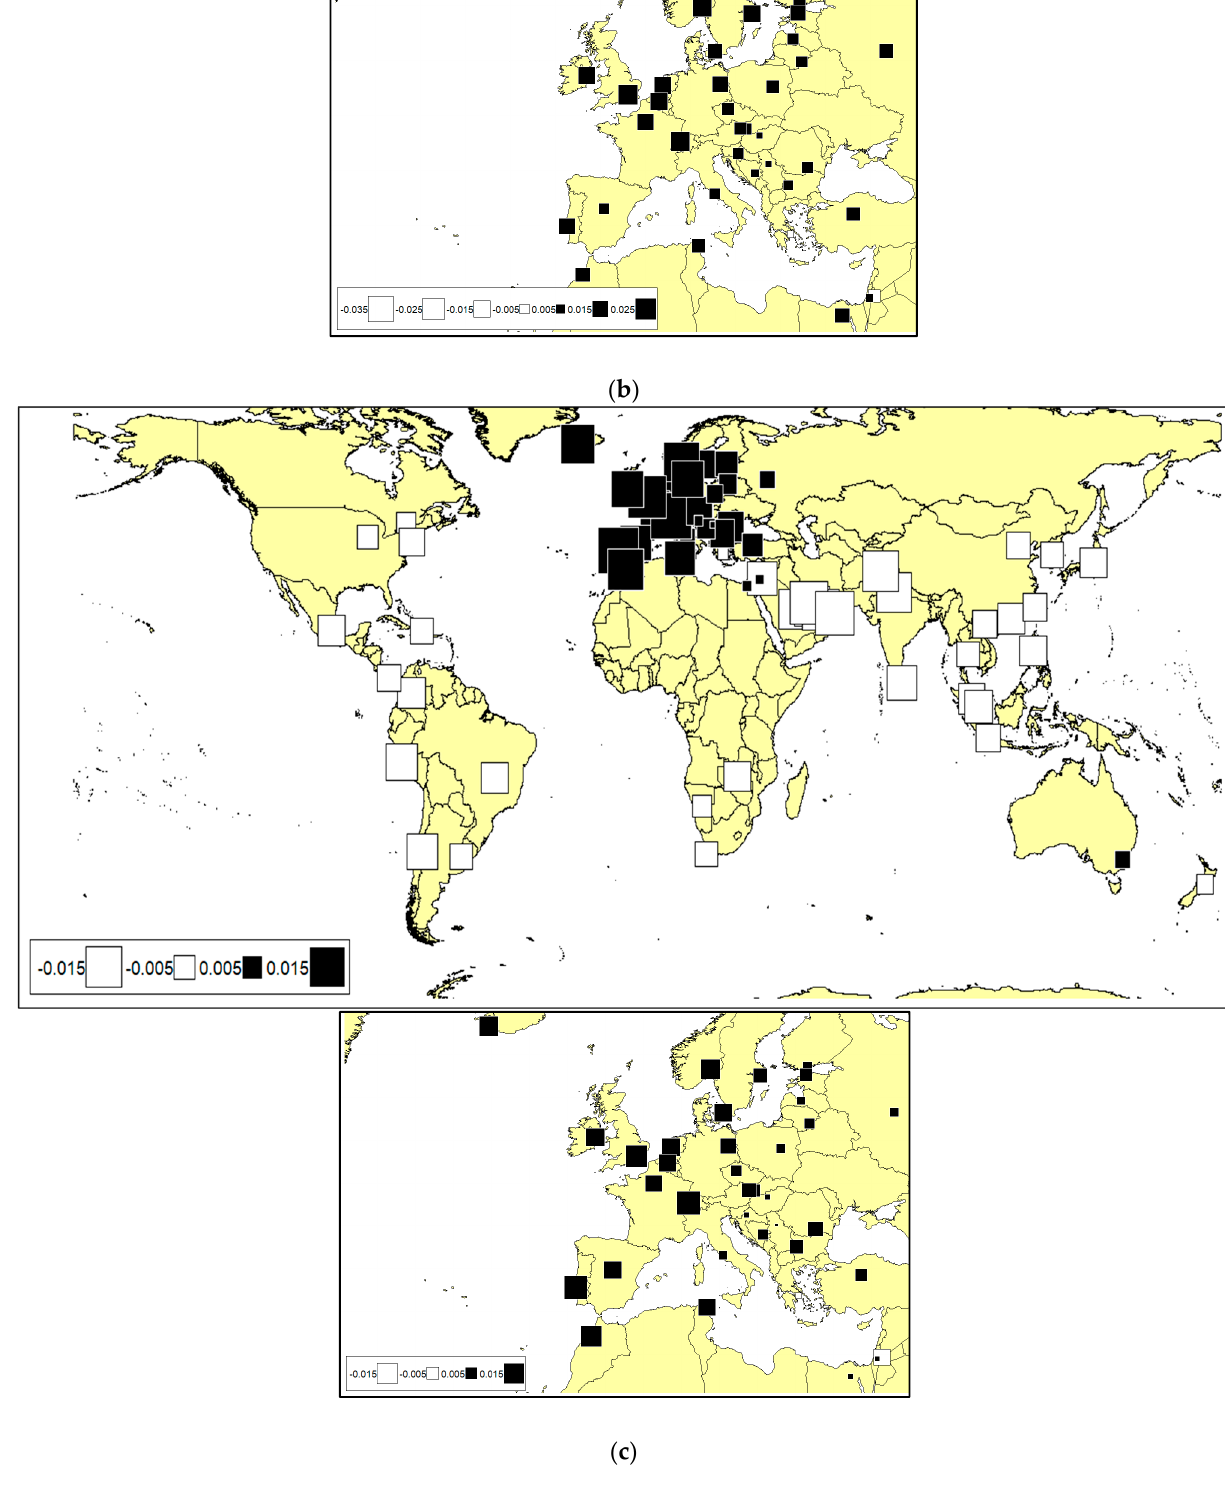
Figure 3. Map of projected first positive PC scores from FASPCA and KNN Connection Network; the smaller map below each bigger map is the zoom-in of Europe: ( a ) period 1; ( b ) period 2; ( c ) period 3.